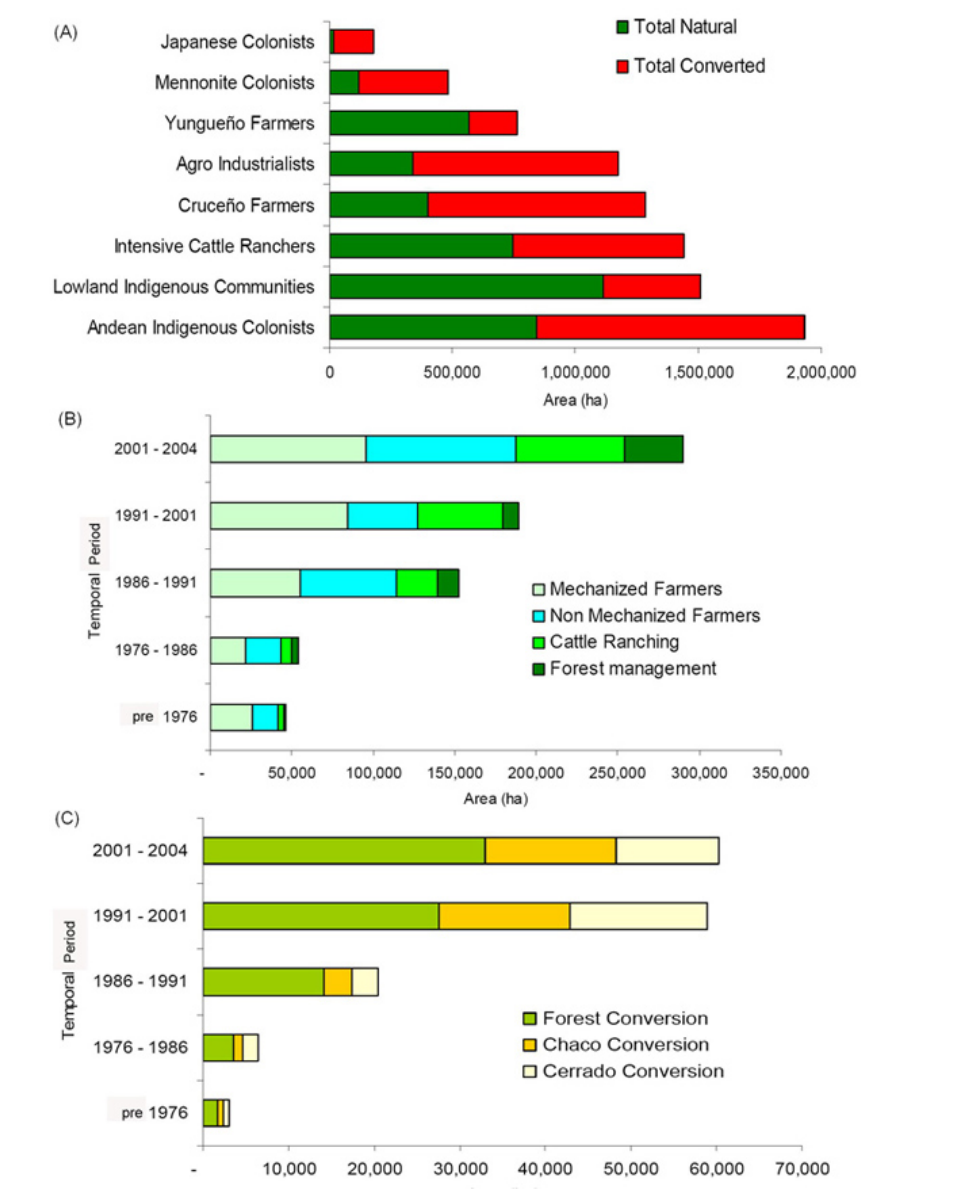
Fig. 2. (A) Remnant habitat and total land-cover change (1976–2004) for eight groups that depend on habitat conversion as part of the production strategy. (B) Cumulative land-cover change according to production system and access to technology. Nonmechanized indigenous Andean colonists have been acquiring mechanized technology in selected colonization zones (see Table 3), and both cattle ranching groups establish pastures using a variety of technologies ranging from manual labor with chain saws to the use of bulldozers and chains. (C) Cumulative land-cover change over five temporal periods for both intensive and extensive cattle ranchers. Habitat conversion has increased over time while also expanding to include a broader range of vegetation